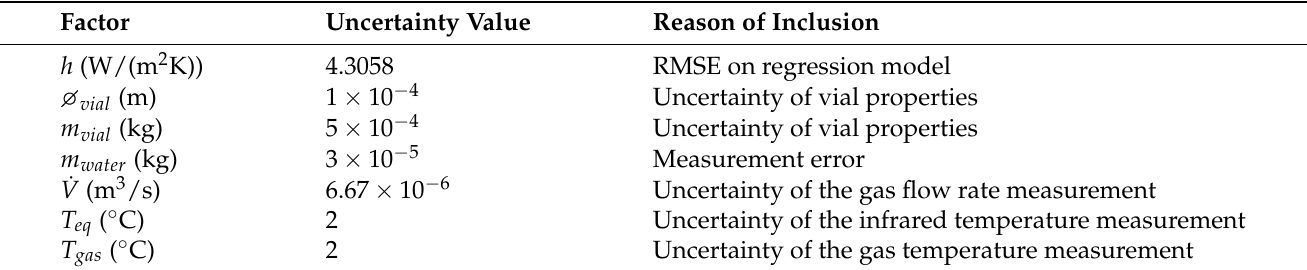
Table 1. Input parameters and their uncertainty level for the UA and